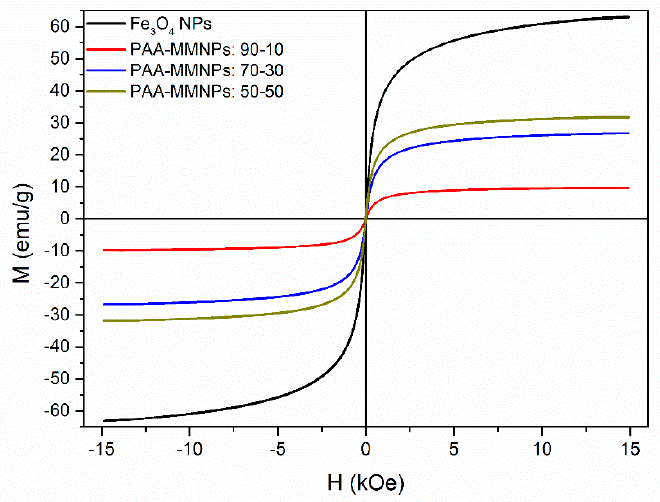
Figure 7. Vibrating sample magnetometry (VSM) magnetization curves of the Fe 3 O 4 nanoparticles and the nanocomposites hydrogels .